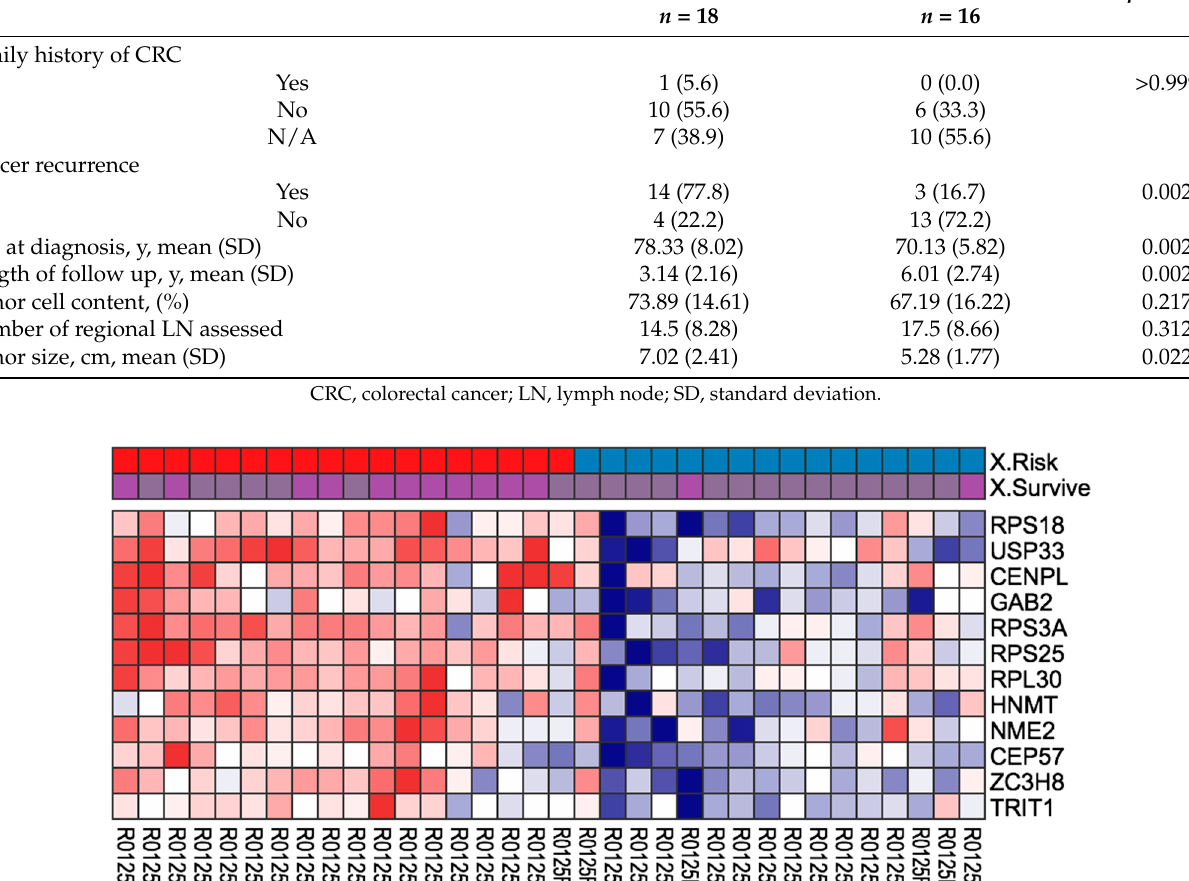
Figure 2. Internal and external validations of three developed models for disease-specific survival in mucinous colorectal cancer. The model shows reasonable discrimination in SEER database arrayexpress datasets. RMSE, root mean square error.